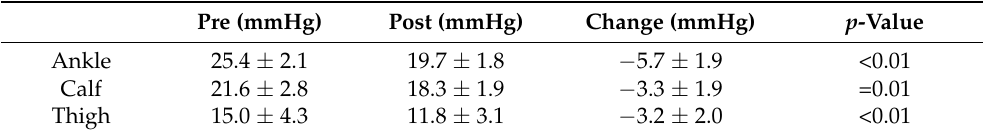
Table 2. Applied pressure measurements (mean ± SD [mmHg]) for full length lower limb compres- sion garment at the ankle, calf, and thigh. Pre to post 6 weeks of military training. Pre (mmHg) Post (mmHg) Change (mmHg)